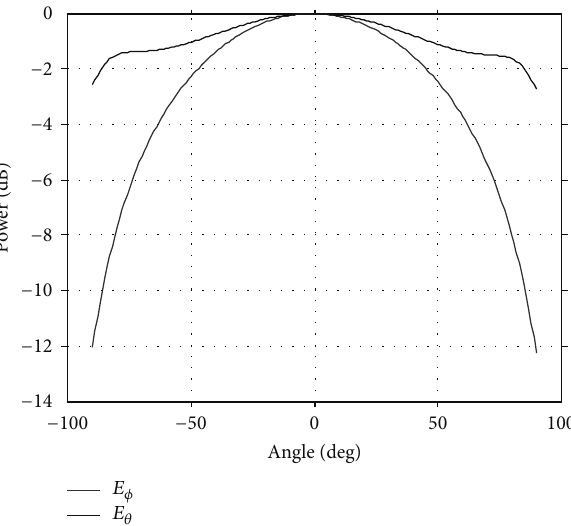
Figure 13: Radiation pattern of circular waveguide at 𝑟 = 0.4𝜆 (1.28 cm).